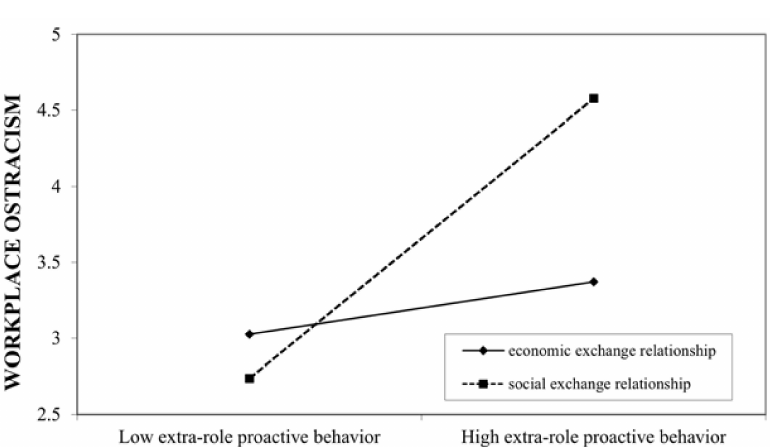
Figure 2. The interactive effect of extra-role proactive behavior and exchange relationship in HR practices on workplace ostracism.